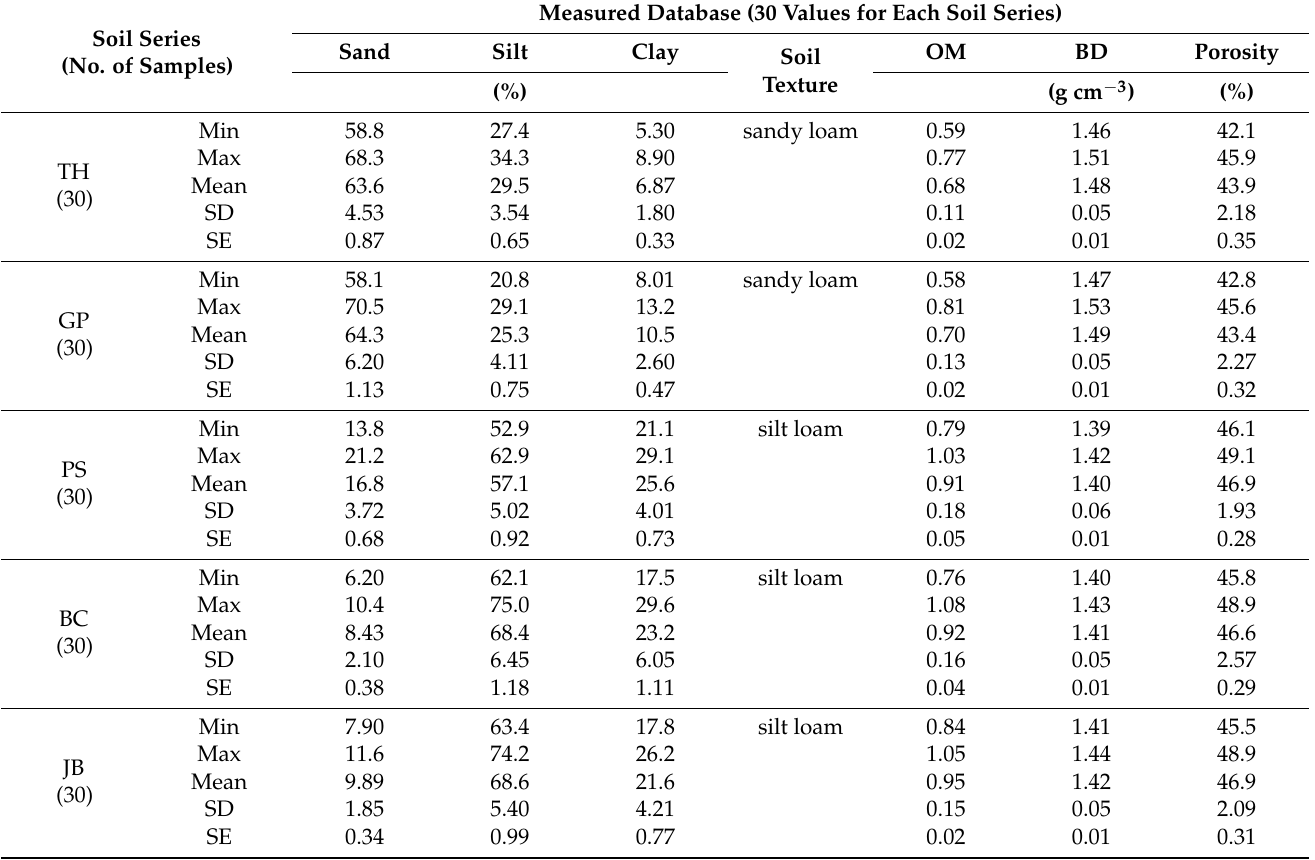
Table 2. Ranges of soil texture and other information of Ap horizons of five-soil series used for PTF.